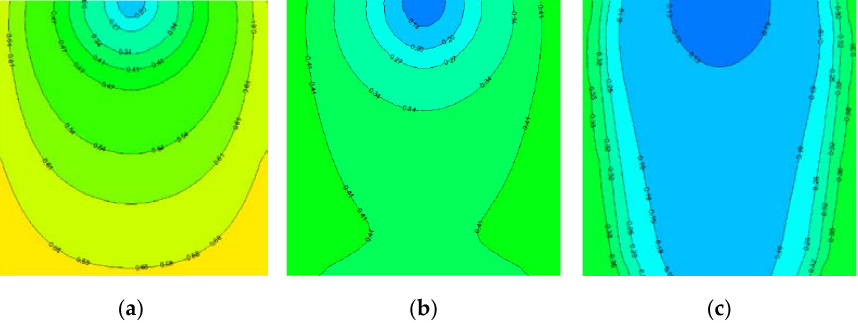
Figure 14. Remaining oil distribution of each layer after subsequent water flooding stage of Figure 3: ( a ) low-permeability layer, ( b ) medium-permeability layer, ( c ) high-permeability layer. Table 8. The remaining oil saturation (%) results of Figure 3 .